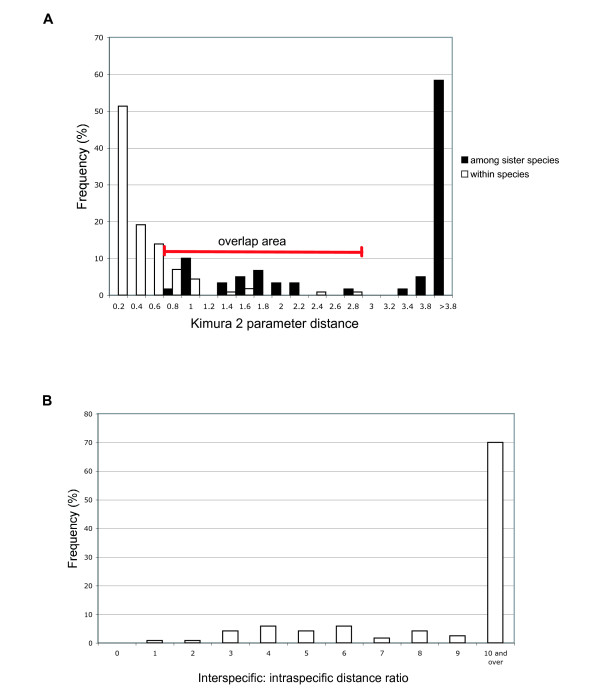
Levels of intraspecific and interspecific distances of sister-species of birds. a) Frequency distribution of K2P intraspecific and interspecific genetic distances between sister-species. b) Frequency distribution of the ratios of K2P interspecific: intraspecific distances in sister species of birds.